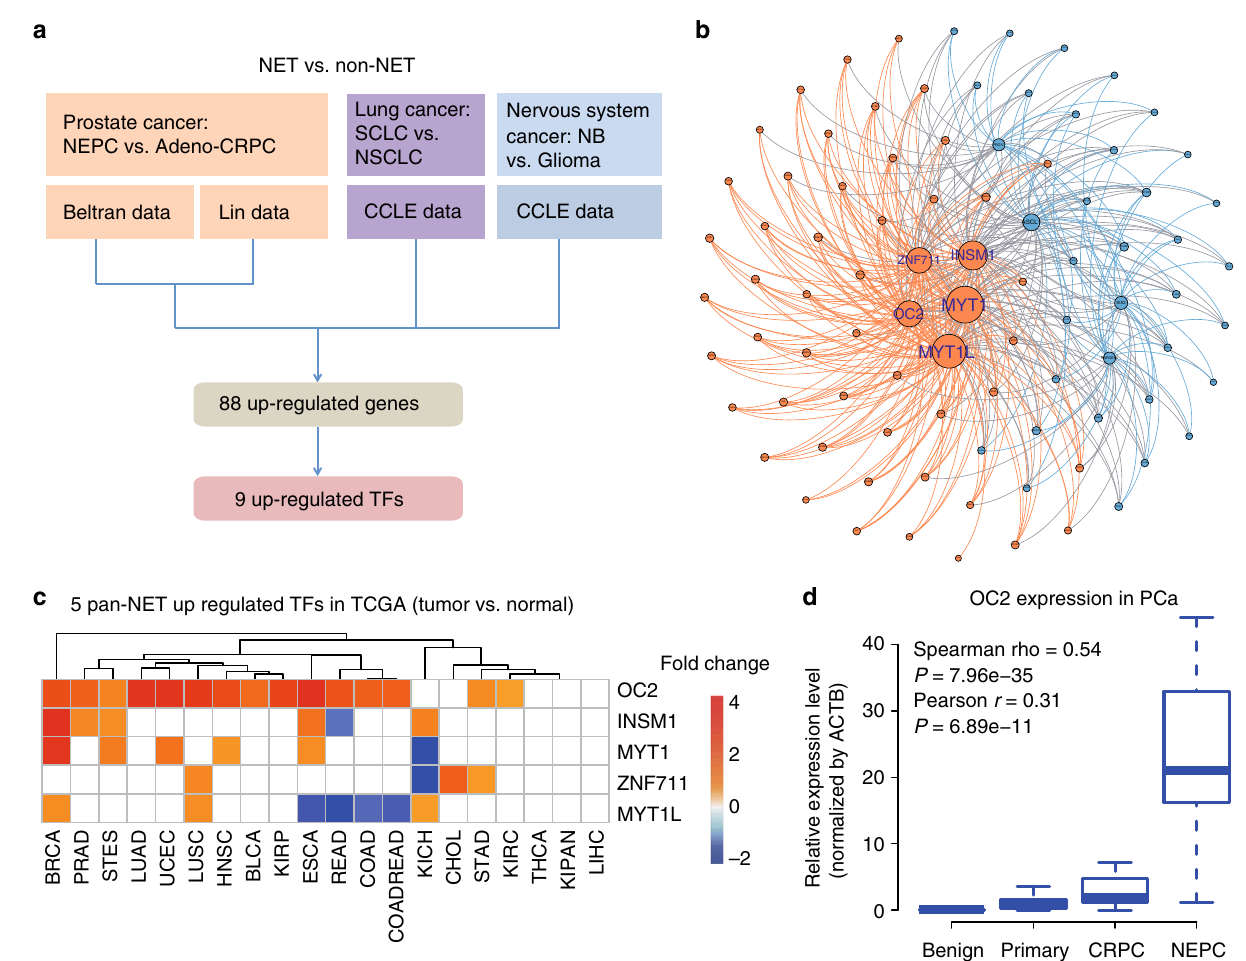
Fig. 1 Pan-cancer analysis identi fi es ONECUT2 as a potential master transcriptional regulator of neuroendocrine tumors. a Schematic illustration of pan- NET analysis (see Methods section and Supplementary Figure 1a for details). Ninety-three genes, including nine transcription factors, were commonly upregulated in NETs compared to the non-NET counterparts within the same cancer types. NET neuroendocrine tumor, NEPC neuroendocrine prostate cancer, Adeno-CRPC castration-resistant prostatic adenocarcinoma, SCLC small-cell lung cancer, NSCLC non-small-cell lung cancer (exclusive of large cell lung cancer), NB neuroblastoma, CCLE Cancer Cell Line Encyclopedia. b Network analysis of nine TFs and 79 non-TF genes commonly upregulated in poorly differentiated NETs. These 88 genes were classi fi ed into two communities using GEPHI, as labeled by color (orange and cyan). c Dysregulation of the fi ve TFs from the major community from panel b in 20 cancer types from TCGA. log 2 transformed fold changes represent difference in expression between tumor and normal tissue. Colored cells indicate signi fi cant expression changes (absolute-value of the log 2 (fold change) > 1 and P < 0.05). The Wilcoxon rank sum test was used to calculate P -values. d ONECUT2 expression in benign prostate tissues and prostate tumors. RNA-Seq data of 52 benign prostate tissues and 333 primary PCa were retrieved from TCGA. RNA-Seq data of 34 adeno-CRPC and 15 NEPC were retrieved from the Beltran dataset. Expression levels as measured by RPKM were normalized by housekeeping gene